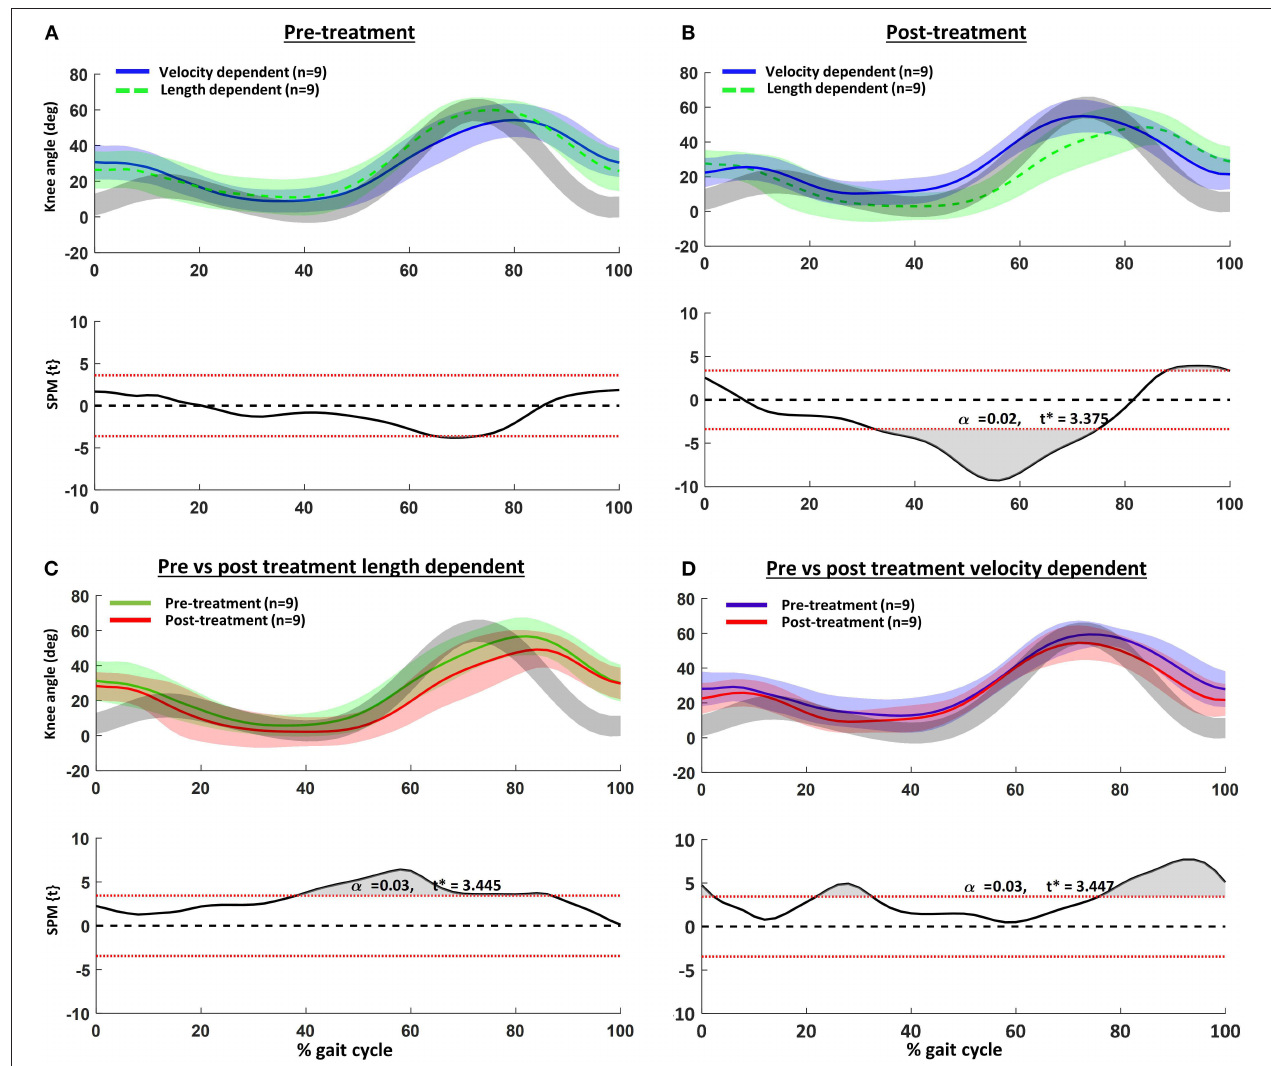
FIGURE 2 | Knee kinematics in the sagittal plane vs. normalized gait cycle and results of the statistical parametric mapping (SPM): (A) pre- and (B) post-treatment velocity vs. length-dependent muscles; (C) pre- vs. post-treatment for the length dependent muscles; and (D) pre- vs. post-treatment for the velocity dependent muscles. Gray curves are from a representative database of typically developing